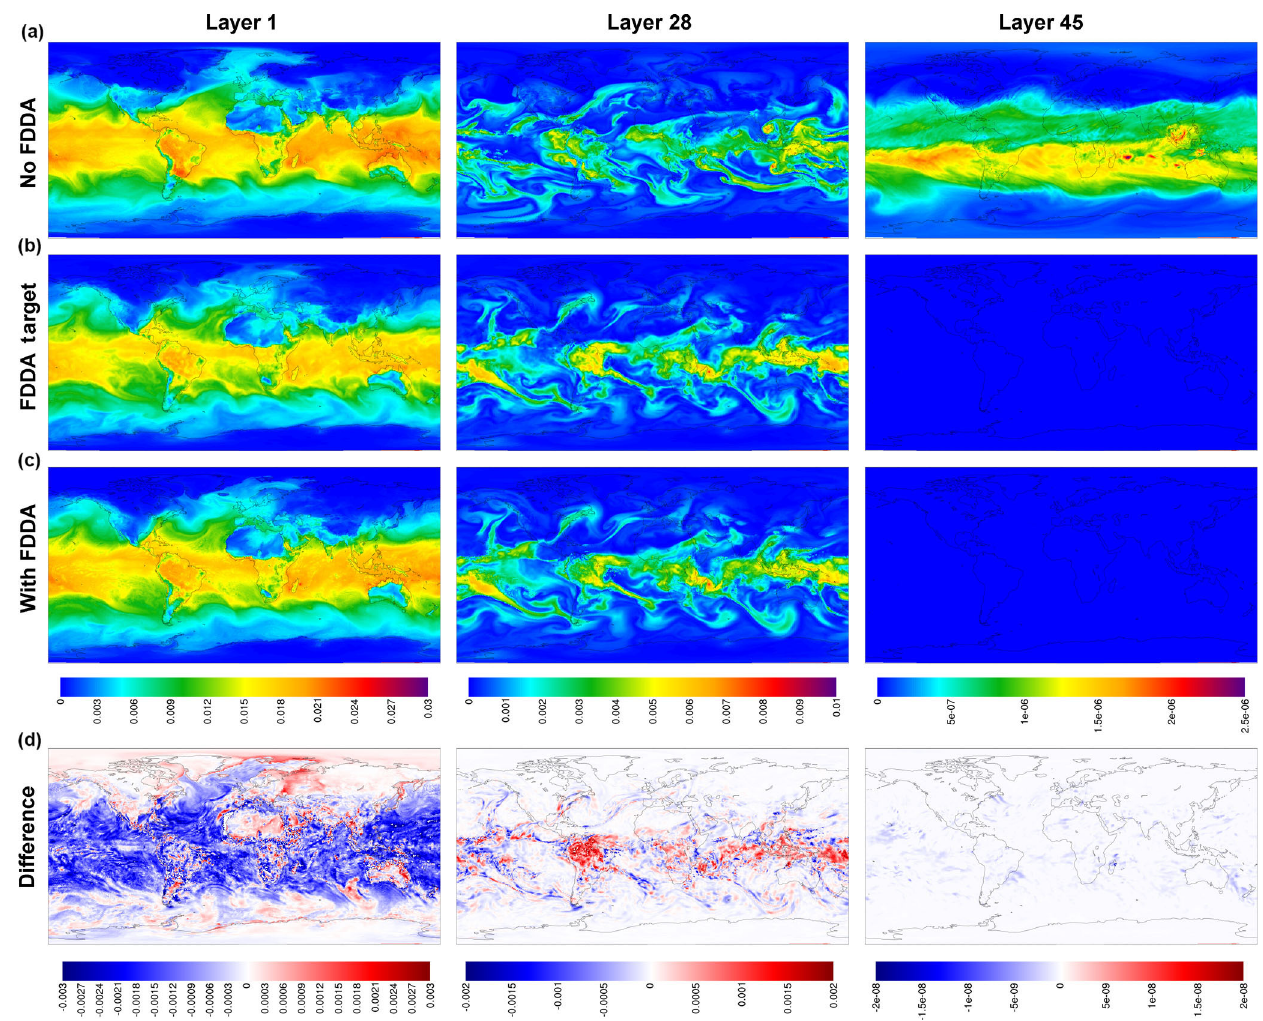
Figure 6. MPAS-A simulation results without FDDA (a) , FDDA target fields (b) , MPAS-A results with FDDA (c) , and FDDA target minus MPAS-A with FDDA (d) for water vapor mixing ratio (kgkg − 1 ) in layers 1, 28, and 45, for 00:00UTC on 31 January 2013, 30 days into the